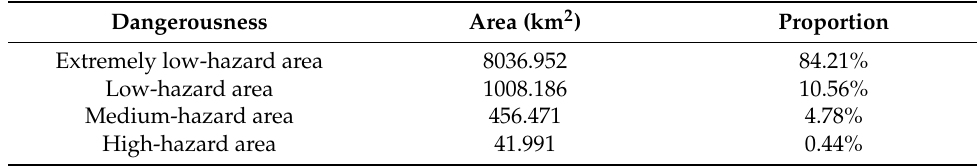
Table 7. Subjective weights and maximum eigenvalues of vulnerability assessment factors.